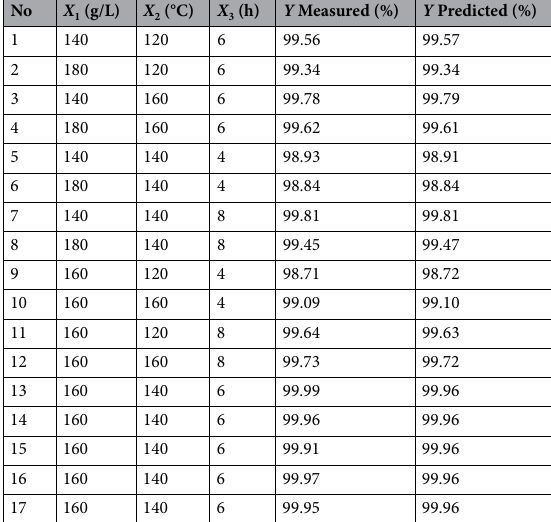
Table 2. Experimental design matrix, experimental results and predicted purity of TiO 2